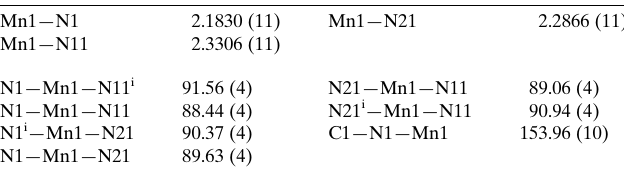
Table 1 Selected geometric parameters (A˚ , (cid:2) ) for 1 .